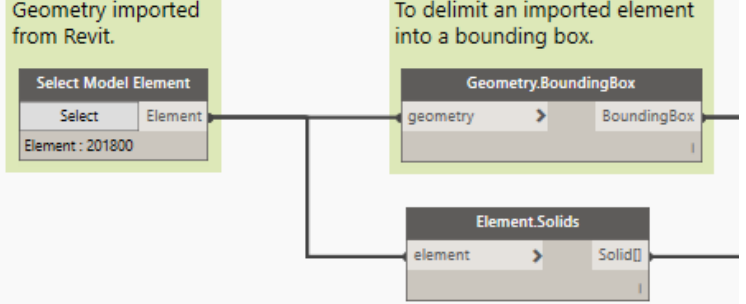
Figure A3. Creation of the Bounding Box on the construction element.